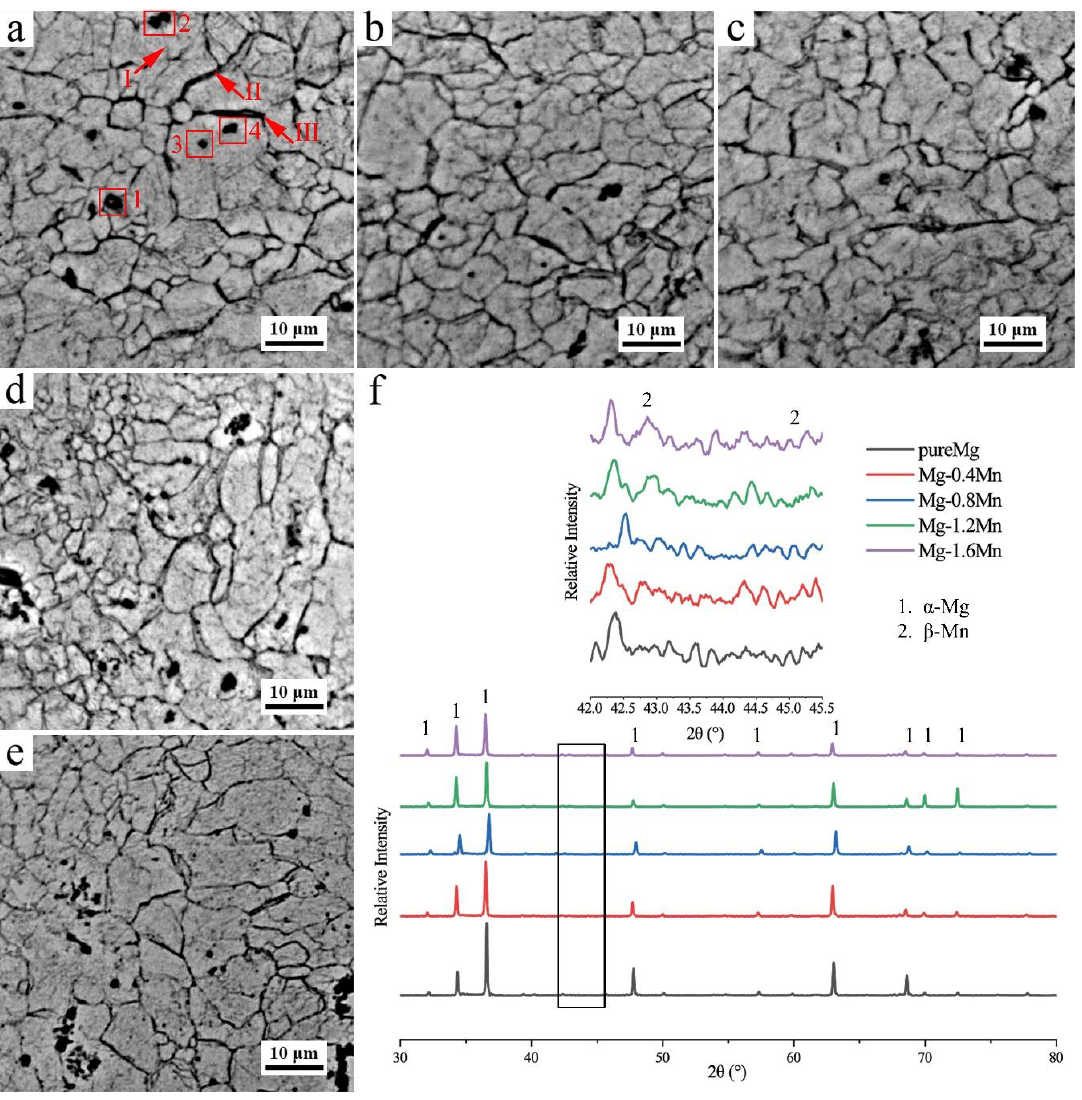
Figure 2. Optical microstructures and XRD patterns of the SLMed Mg- x Mn: ( a ) x = 0, ( b ) x = 0.4, ( c ) x = 0.8, ( d ) x = 1.2, ( e ) x = 1.6, and ( f ) XRD patterns.